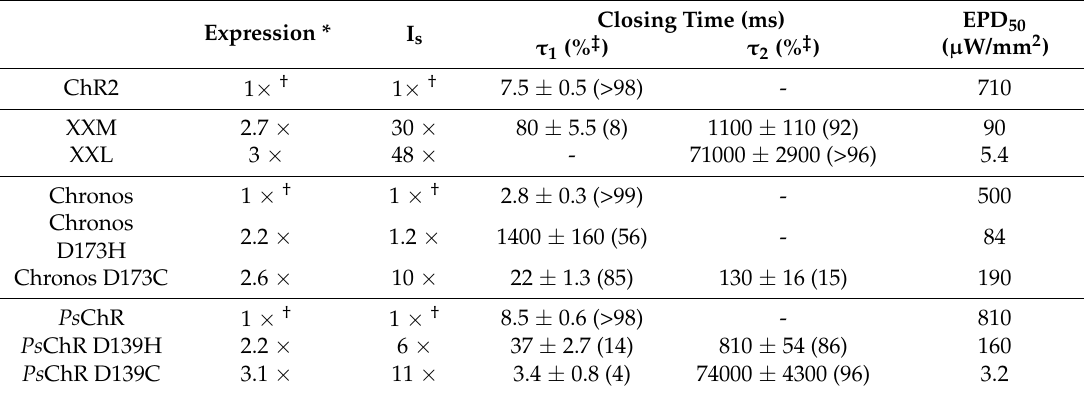
† , expression or photocurrent of corresponding wild type was normalized as 1 × . Is, stationary (plateau) current. ‡ ,